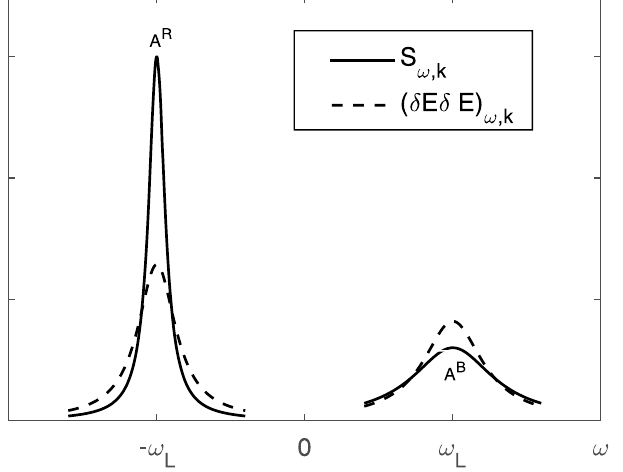
Figure 1. The dynamic electron structure factor ω S k ( , ) e (solid line) and the spectral function of electrostatic field fluctuations δ δ ω E E ( ) (dashed line) as a function of k ,